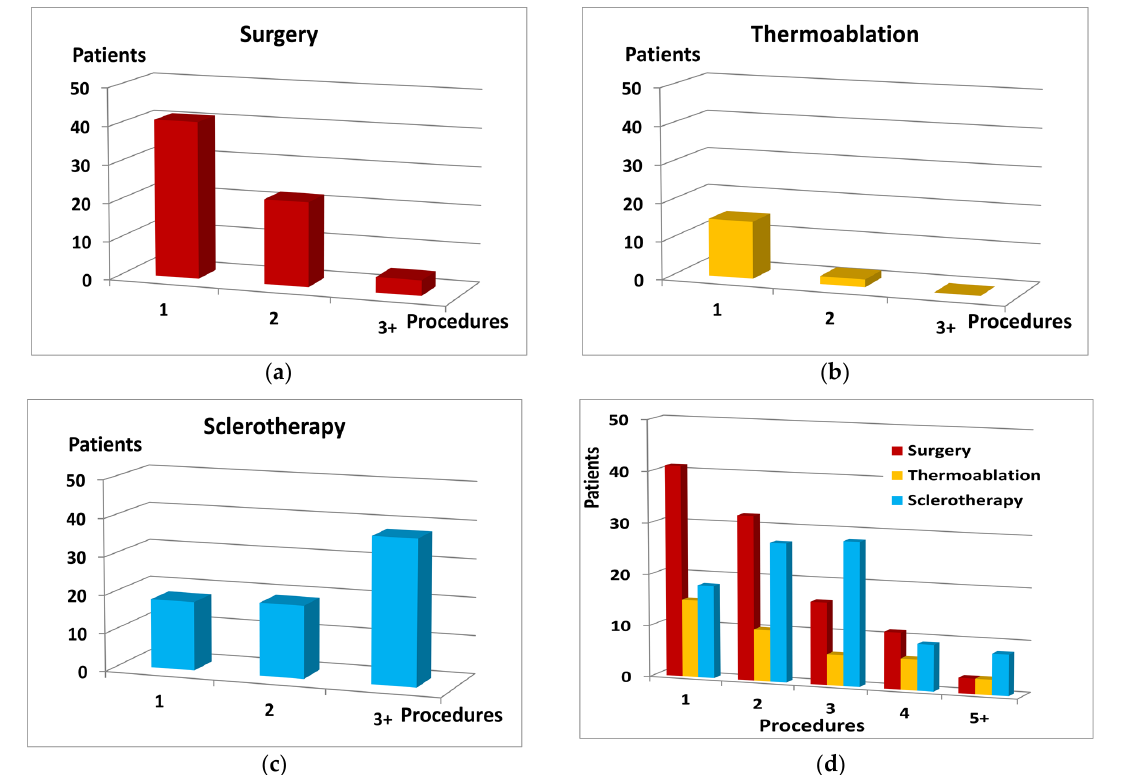
Figure 1. The number of procedures (horizontal axis) and distribution of the patient number (vertical axis) in regards to: ( a ) surgery as the only procedure; ( b ) thermoablation as the only procedure; ( c ) sclerotherapy as the only procedure; ( d ) each procedure alone or in combination with other methods. Table 2. Characteristics of the “Recurrence” group. The values shown in the table represent the mean (median) ±SD, or the number (percent) of patients in the group, respectively.